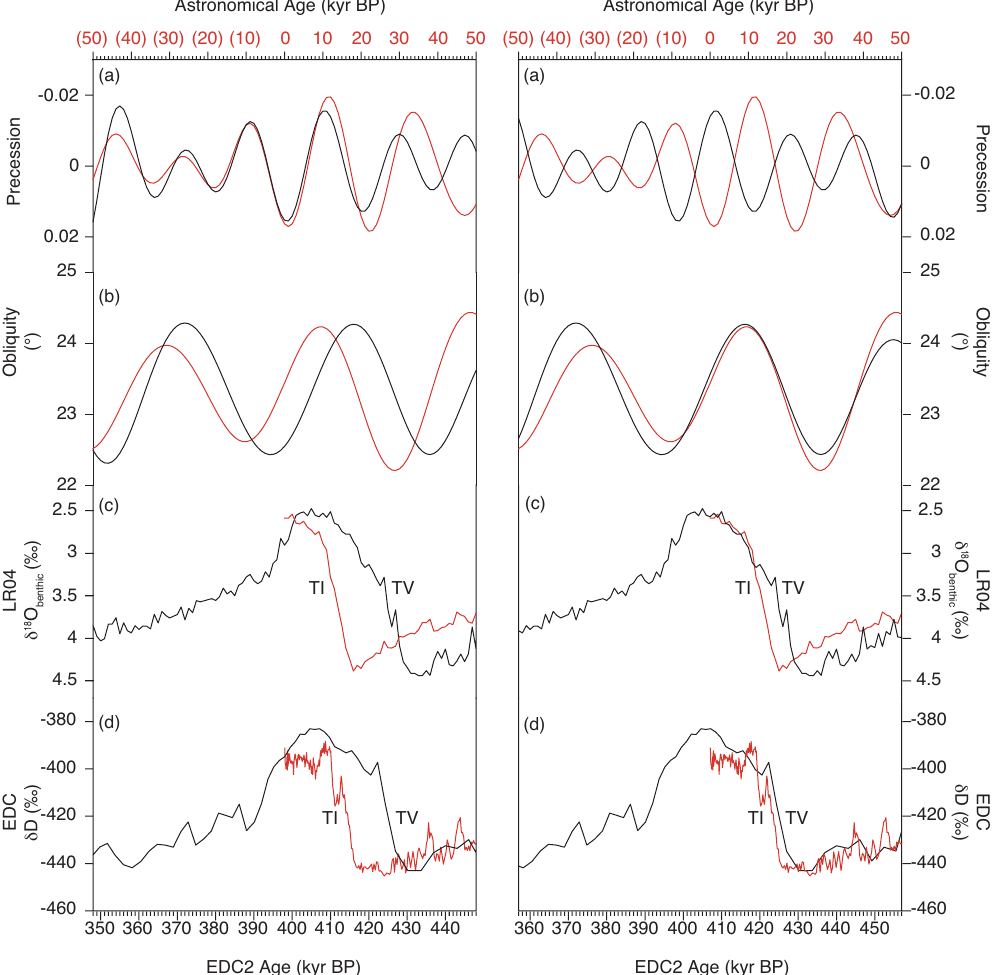
Fig. 1. Comparison of two alignment schemes between the past and future 50kyr (red) and a 100-kyr interval encompassing MIS 11 (black) (after Masson-Delmotte et al., 2006). Left panel shows synchronization of the precession signal and right panel synchronization of the obliquity signal and also of Terminations I and V in the deuterium record of the EPICA Dome C (EDC) ice core, Antarctica. (a) precession index, plotted on an inverse vertical axis (Berger and Loutre, 1991); (b) obliquity (Berger and Loutre, 1991); (c) δ 18 O benthic record from the LR04 stack (Lisiecki and Raymo, 2005), plotted on its own timescale; (d) Deuterium ( δD ) composition of ice in EDC ice core (EPICA Community Members, 2004). Ages in parentheses denote thousand years after present (kyr AP). TI and TV denote Terminations I and V, respectively. The EPICA data in this figure are plotted on the EDC2 timescale used in the EPICA Community Members (2004) paper where the alignment was originally made. In other figures, EPICA data are shown on the more recent EDC3 timescale (Jouzel et al.,